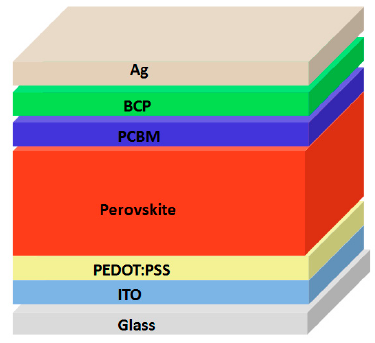
Figure 1. Device structure of p-i-n MA 0.7 FA 0.3 Pb(I 0.9 Br 0.1 ) 3 PSCs.